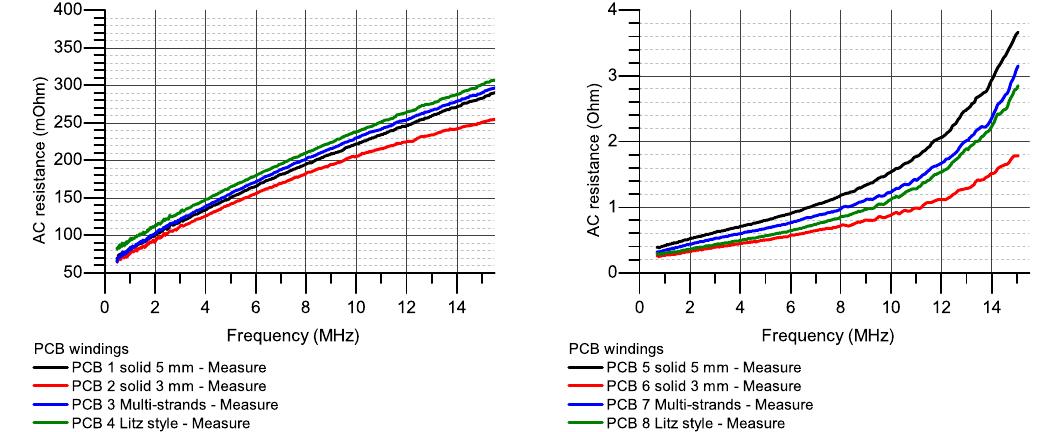
Figure 20. AC resistances of 3-turn windings ( Left ) and 7-turn windings ( Right ) at higher frequency